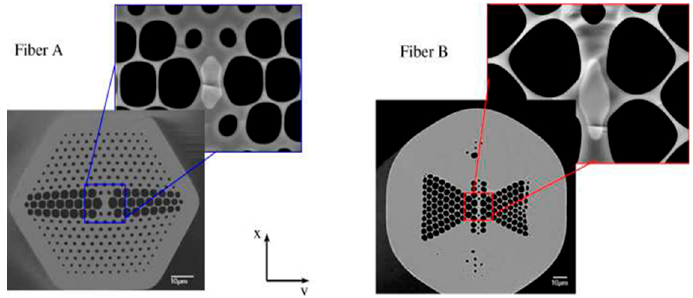
Figure 13. SEM images of two birefringent microstructured fabricated fibers with enhanced sensitivity for the measurement of hydrostatic pressure (Reproduced from [59], with the permission of OSA publishing).